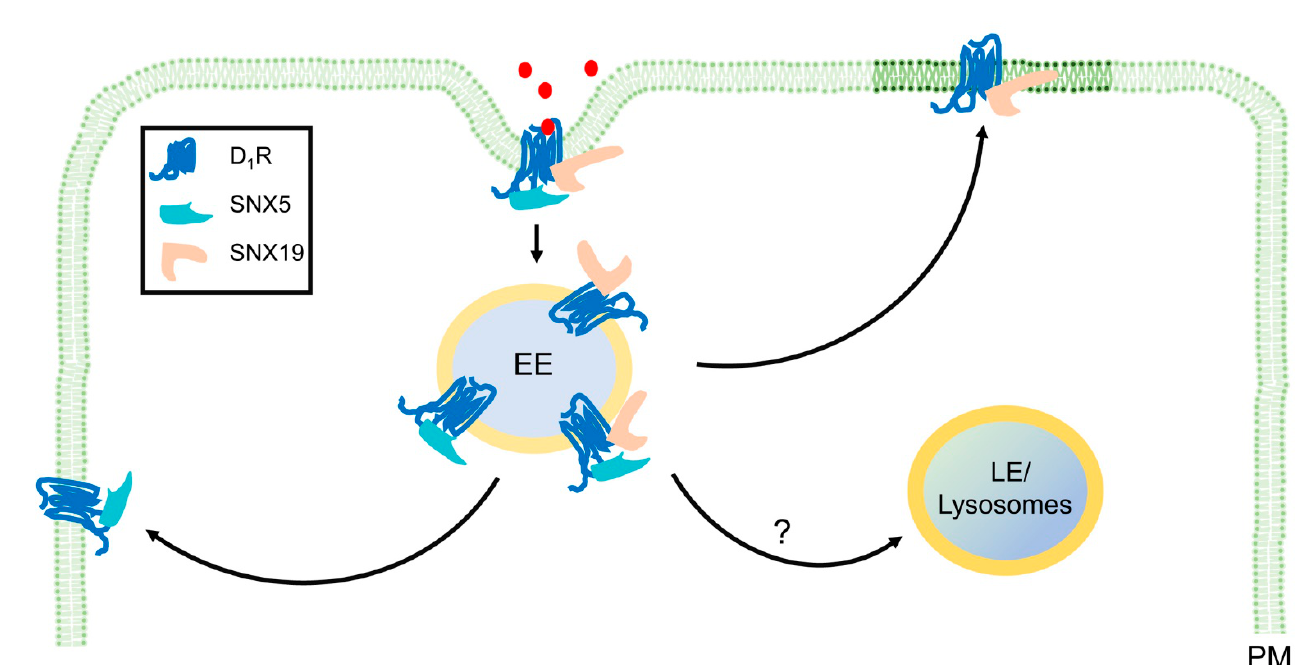
Figure 2. Regulation of D 1 R signaling and membrane trafficking by SNX5 and SNX19 in human renal proximal tubule cells. D 1 R is stimulated by dopamine or D 1 R agonists, resulting in the activation of G α s and increase in C AMP production (not shown). Both SNX5 and SNX19 interact to internalize D 1 R in early endosomes (EE). It is not clear if SNX5 and SNX19 participate in the subsequent trafficking of D 1 R in late endosomes (LE) and lysosomes. SNX5 and SNX19 differently regulate D 1 R recycling; SNX5 may regulate D 1 R recycling through phosphorylation (not shown), while SNX19 regulates D 1 R recycling through palmitoylation and targeting D 1 R to lipid rafts (dark green). Red dots, dopamine, fenoldopam, or other D 1 R